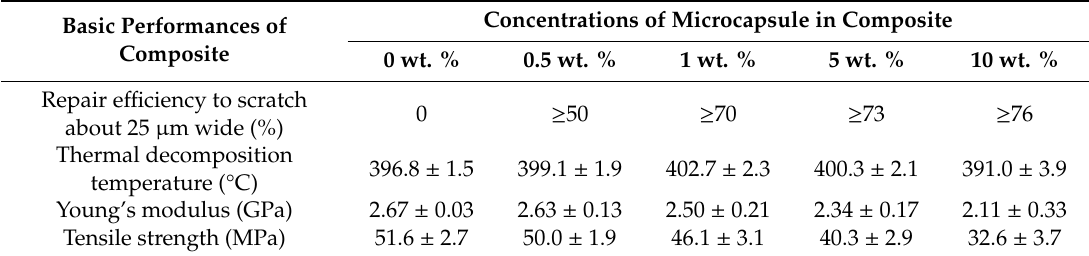
Table 1. Basic performances of composite with di ff erent concentrations of microcapsule. Basic Performances of